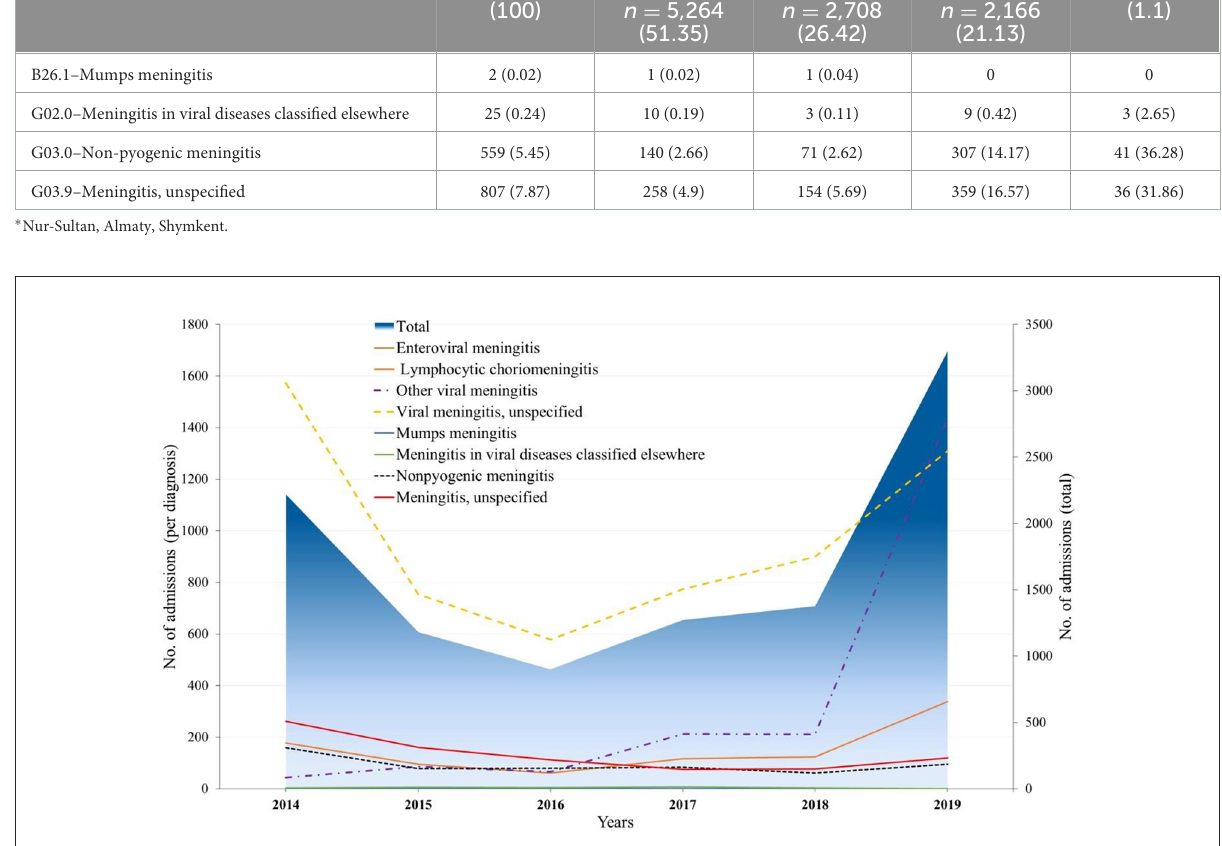
FIGURE2 National admission trends with the diagnosis of VM for the period of